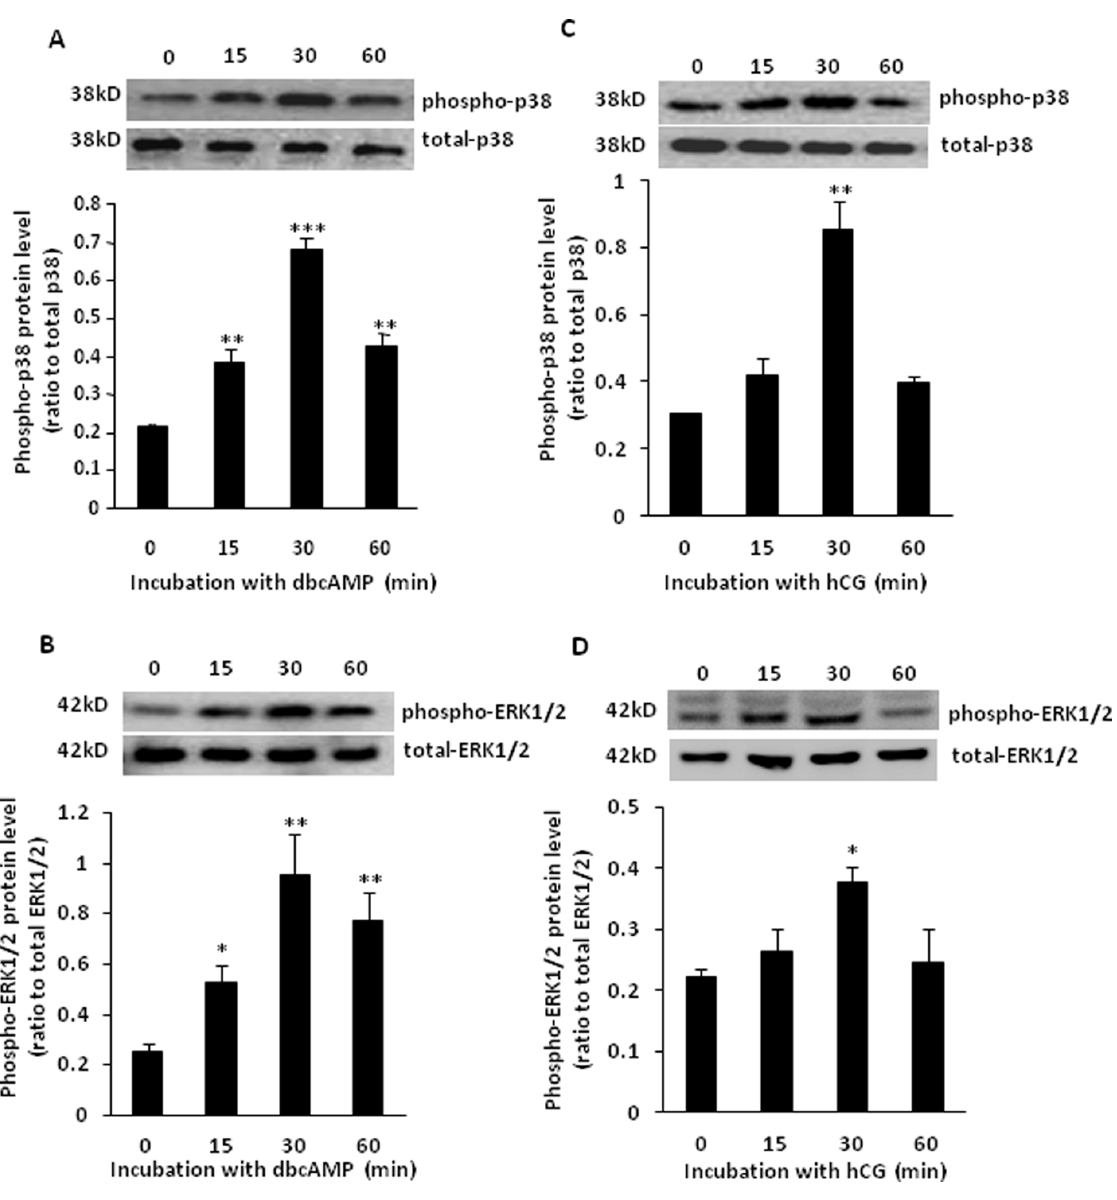
Figure 1. Phosphorylation of p38 MAPK (P-p38) and ERK1/2 induced by dbcAMP (100 m M) and hCG (10 IU/ml) in human placental syncytiotrophoblasts. Upper panels of each bar graph are the representative blots. The bar graphs are the average data of three experiments. *P , 0.05, **P , 0.01,***P , 0.001 versus 0 min. doi:10.1371/journal.pone.0107938.g001 PLOS ONE |